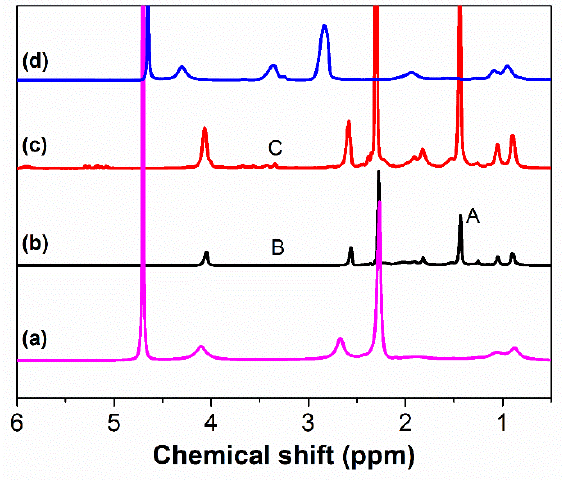
Figure 1. 1 H NMR spectra of CTA-PDMAEMA 4 ( a ), HS-P t BA 2 - b - PDMAEMA 4 ( b ), star-P t BA 2 - b - PDMAEMA 4 ( c ) and star-PAA 2 - b -PDMAEMA 4 ( d ). Using UV-184 as the photoinitiator, the as-prepared block copolymer arms with thiol-end were grafted onto 4-arm, 8-arm, and 12-arm allyl ether via a PITE click reaction. Compared with the 1 H NMR spectrum of HS-P t BA 2 - b -PDMAEMA 4 , the characteristic - OCH 2 C H 2 CH 2 S- peak (C peak) of 8-arm allyl ether was observed in the 1 H NMR spectrum of star-P t BA 2 - b -PDMAEMA 4 (Figure 1c), indicating that the HS-P t BA 2 - b -PDMAEMA 4 arm had been successfully grafted onto the ally ether core by PITE click reaction. After TFA specific hydrolysis the P t BA segment in star-P t BA 2 - b -PDMAEMA 4 was converted to PAA segment, which was determined by the complete disappearance of A peak in Figure 1d. Table 1. Molecular weights and PDI of chain polymers and star-like block copolymers. Sample 𝑴 𝐧,𝐭𝐡 (a) (g·mol − 1 )